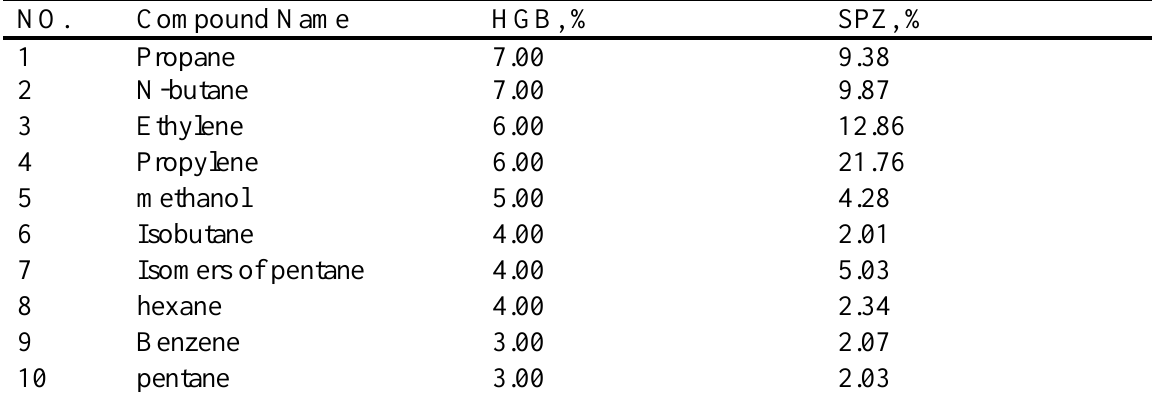
Table 3 . Contribution of VOCs in EI of HGB and EI of the SPZ by mass